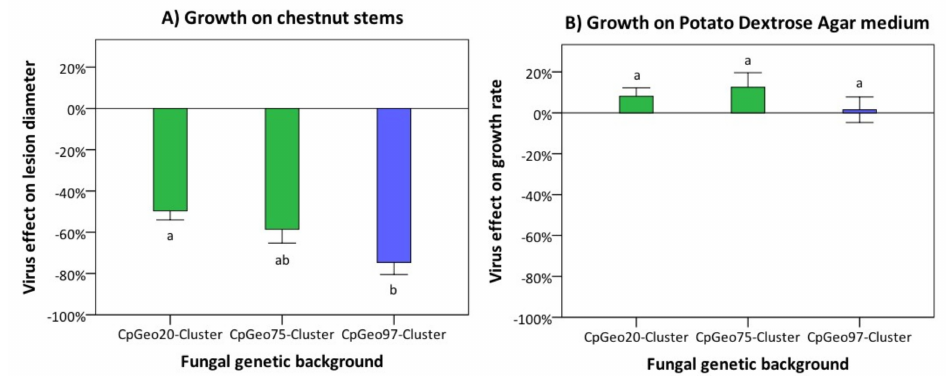
Figure 4. Effect of the Georgian CHV-1 subtype on the growth of its fungal host on dormant chestnut stems ( A ) and on PDA medium ( B ). For analyses, C. parasitica isolates were grouped according to their genetic background into the three genetic clusters CpGeo20 ( n = 10), CpGeo75 ( n = 10), and CpGeo97 ( n = 9). Clusters CpGeo20 and CpGeo75 belong to the Georgian gene pool of C. parasitica , whereas cluster CpGeo97 to the European gene pool (for details on fungal genotypes see Prospero et al. [25]). The virus effect was quantified as the difference in performance between the hypovirus-infected and its isogenic hypovirus-free isolate as percentage of the performance of the hypovirus-free isolate. Error bars represent standard errors. Values with different letters differ significantly ( p < 0.05).